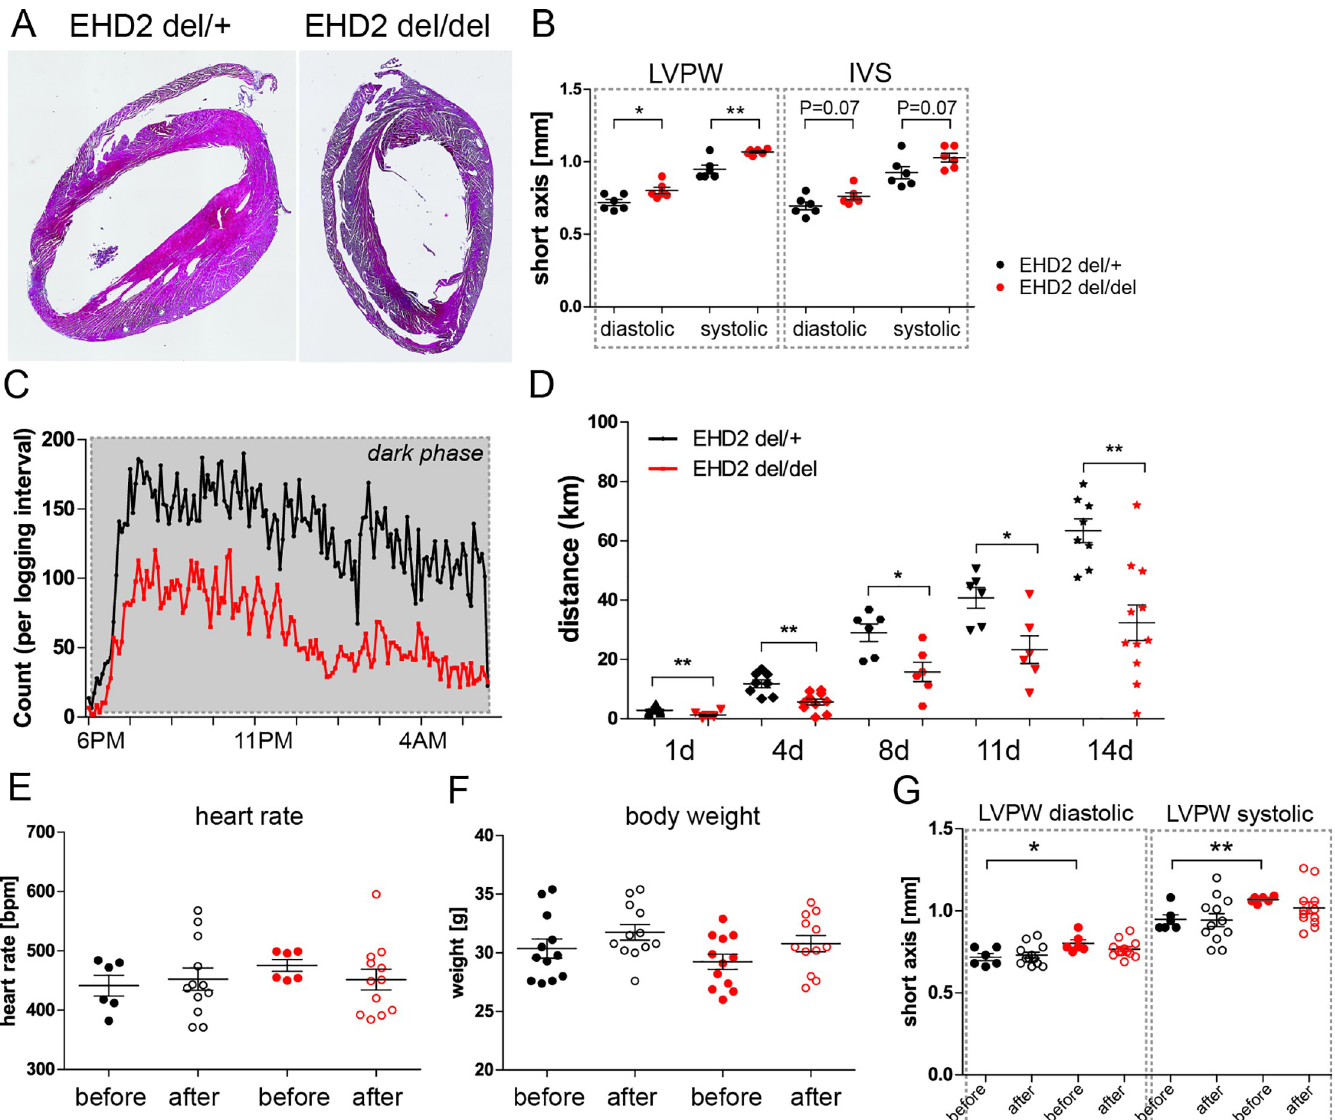
Fig 6. EHD2 del/del mice showed reduced running wheel activity. (A) Heart paraffin sections illustrated no apparent morphological changes in EHD2 del/del compared to EHD2 del/+ mice. (B) Echocardiography measurement of 20 weeks old mice showed an increased left ventricle wall size in EHD2 del/del mice (n = 6). (C) Recorded running wheel activity of EHD2 del/+ and del/del mice during the night phase (n(del/+) = 7, n(del/del) = 8). (D) Measured running distance of EHD2 del/ + and del/del mice over two weeks revealed significantly reduced total running distance for EHD2 del/del mice compared to the control group. (E) Heart rate of EHD2 del/+ and del/del mice before and after the running wheel training (n = 6–12) was not impaired. (F) Body weight was not influenced by the running wheel exercise in EHD2 del/+ and del/del mice (n = 6–12). (G) Left ventricle wall size is aligned after two weeks of running wheel training in EHD2 del/+ and del/del mice (n = 6–12). Graphs illustrate each replicate with mean +/- SE, t-test or Mann Whitney U test were used to calculate significance, � P < 0.05; �� P < 0.001. LVPW–left ventricular posterior wall thickness, IVS–interventricular septum.